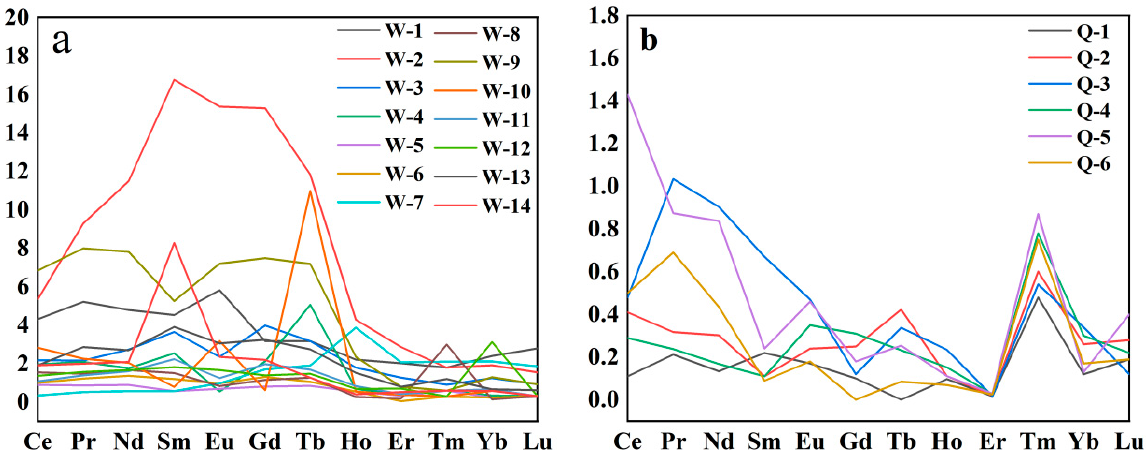
Figure 4. Standard content map of rare earth elements in Guatemalan and Qing dynasty jadeite. ( a ) is Guatemalan jadeite and ( b ) is Qing dynasty